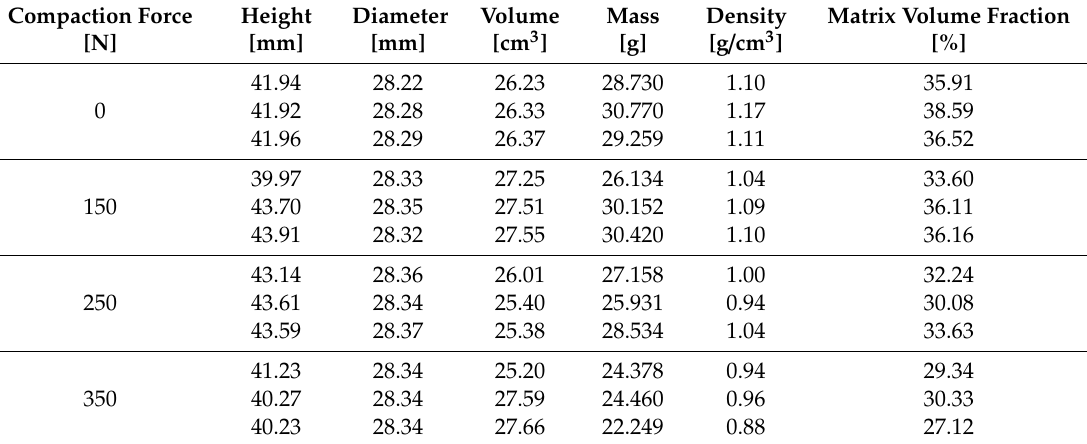
Table A1. Geometric dimensions of samples.